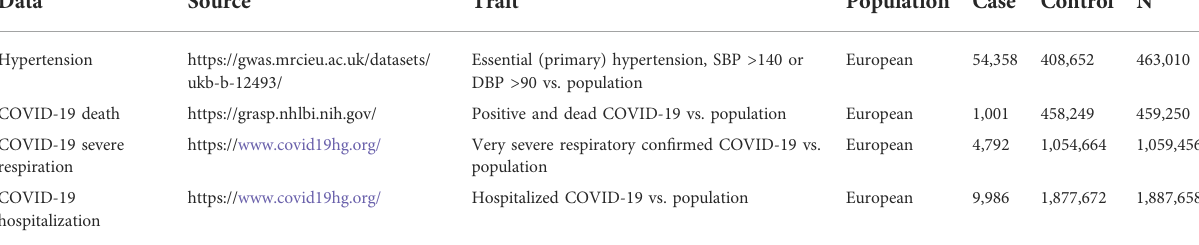
TABLE 2 GWAS summary dataset